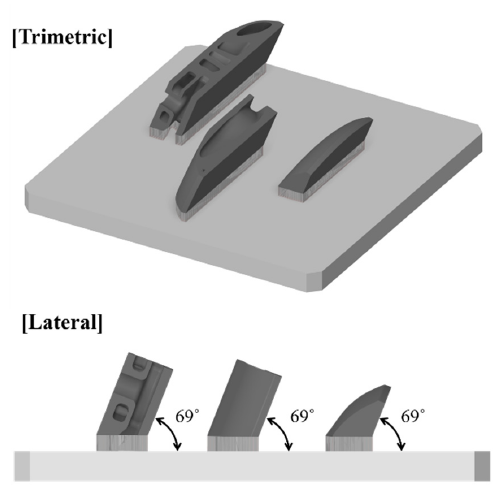
Figure 18. Build orientation of the samples.